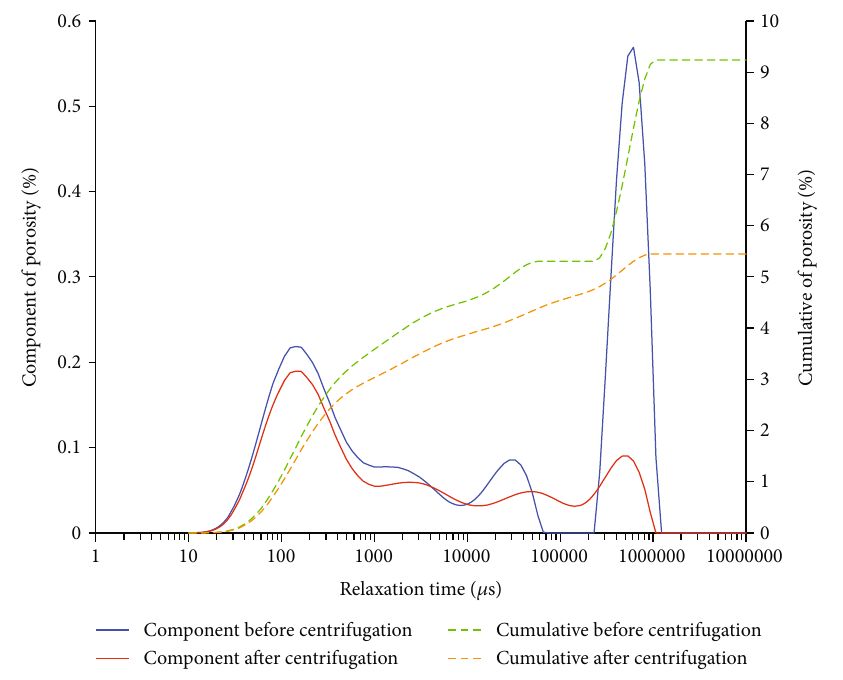
Figure 3: NMR T spectrum of core in well DF51 at 2